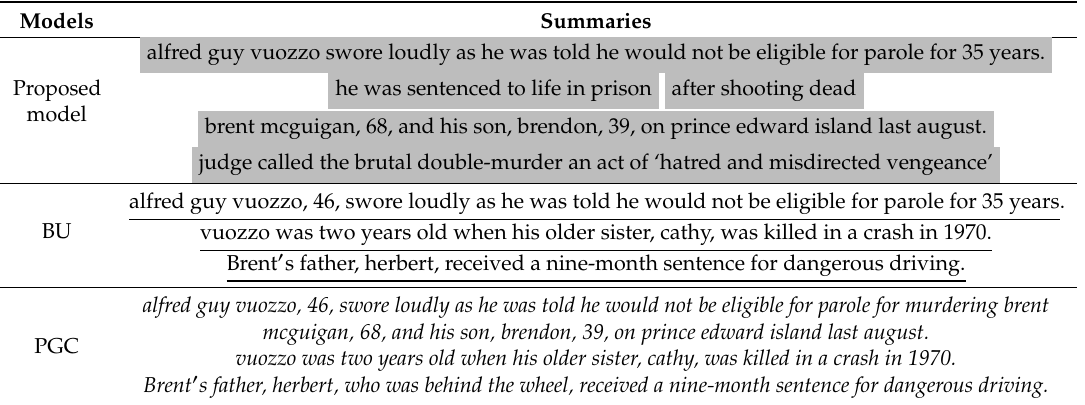
Table 3. Summaries generated by the proposed model and the baseline